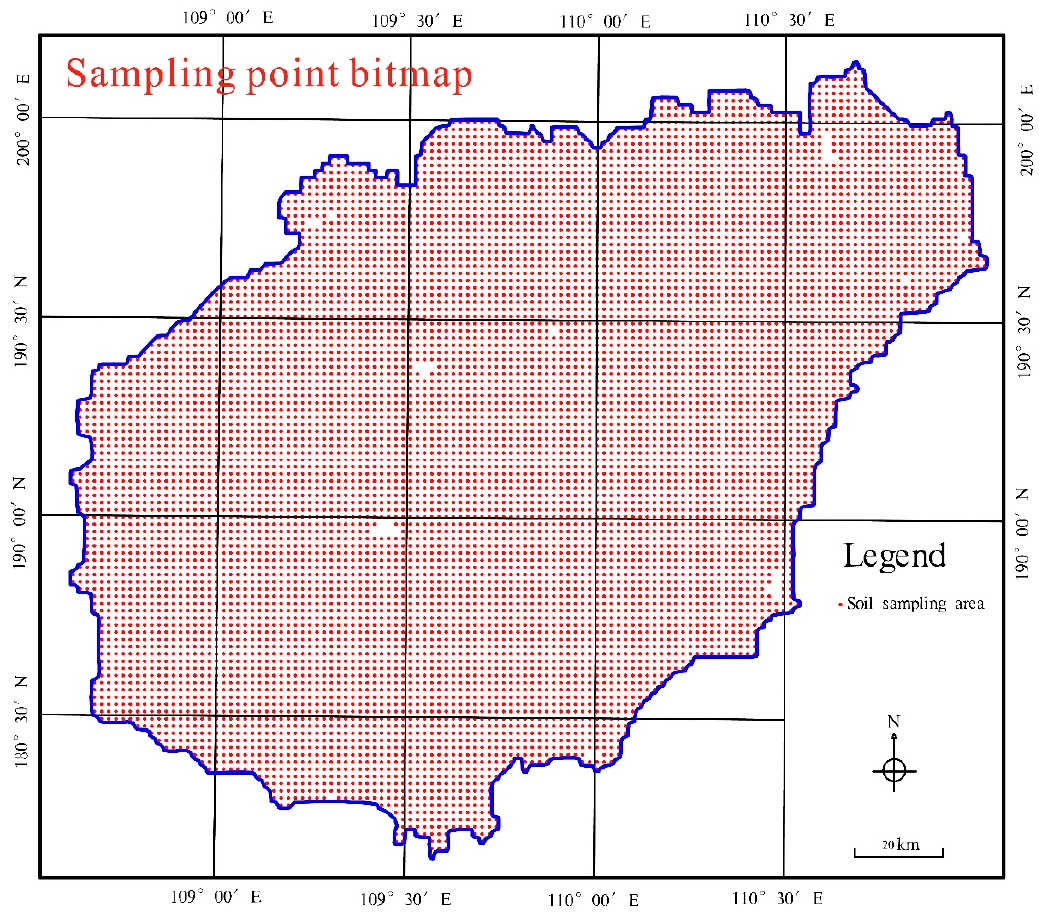
Figure 1. Location of the sampling sites.